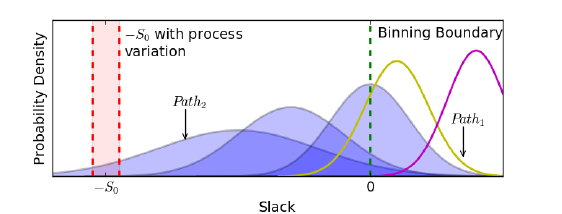
Figure 6. The Binning Critical Path selection and process variation affect the Yield Optimization Rate